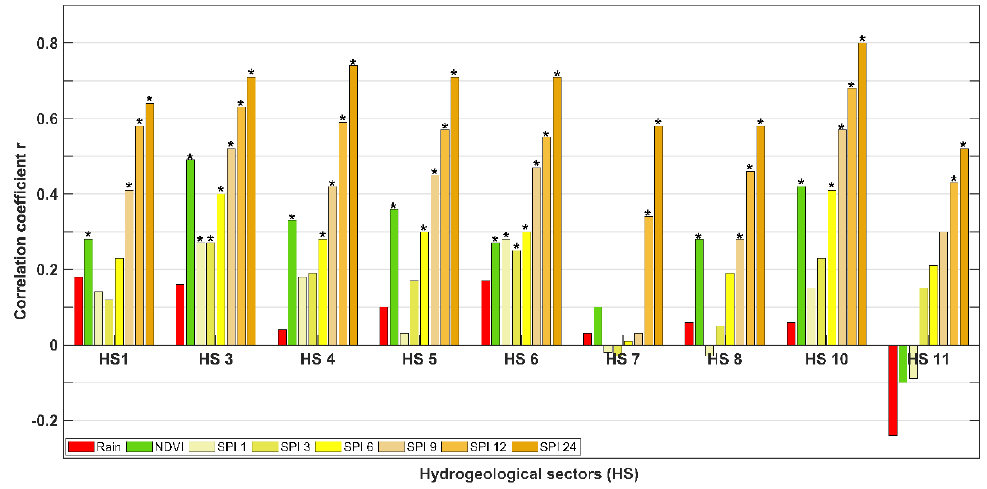
Figure 13. Correlation with GW by hydrological sector (HS) of time series variables (Rainfall, NDVI, SPI1, SPI3, SPI6, SPI9, SP12, and SPI24), significance level of 0.05, from 2002 to 2016. Statistical significance is indicated by (*).